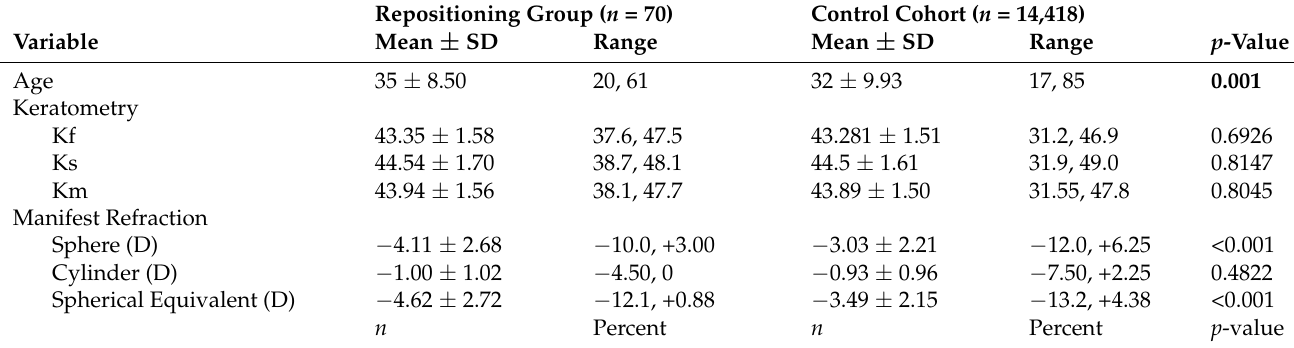
Table 2. Preoperative and intraoperative variable comparison in repositioned eyes vs. control cohort. Repositioning Group ( n =